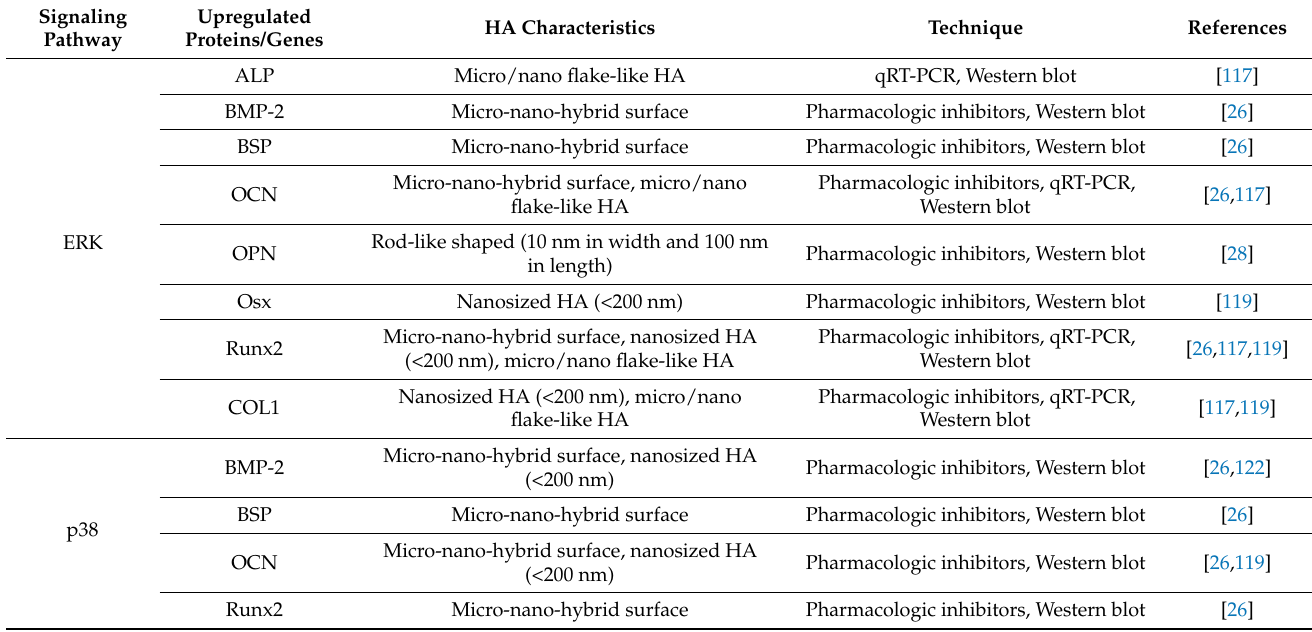
Table 1. Signaling pathways induced by hydroxyapatite